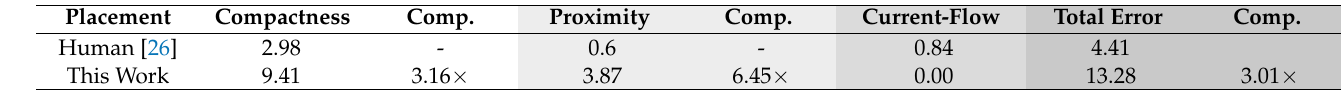
Figure 7. Placements generated by a human designer and the proposed toolbox for the LPLNA [26], along with the total, the proximity, and the current-flow error graphs. ( a ) Human designed placement. ( b ) Toolbox’s generated placement. Table 2. Floorplans’ error comparison for the low ‐ power, low ‐ noise amplifier.